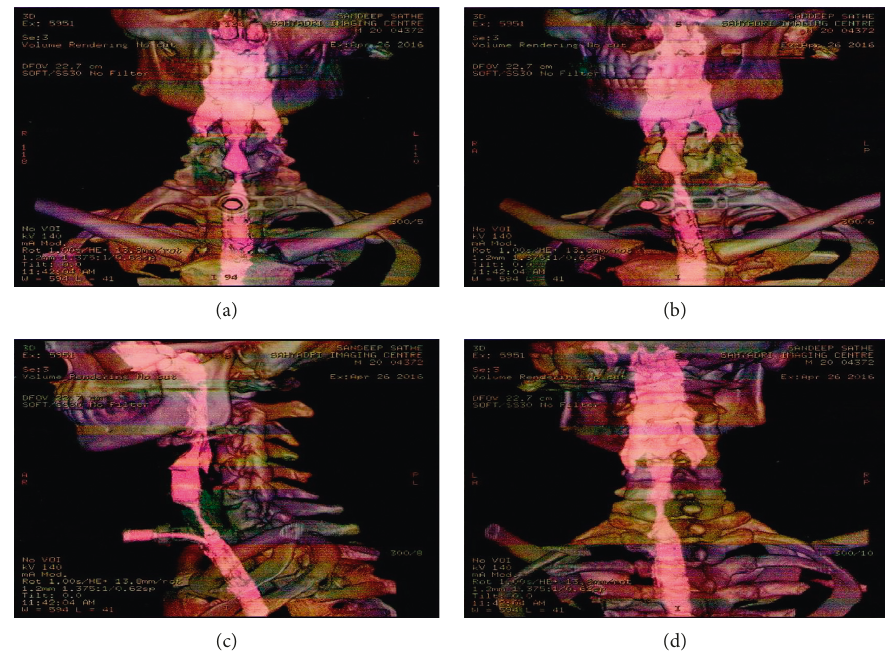
Figure 1: 3D CT neck showing stenotic portion.